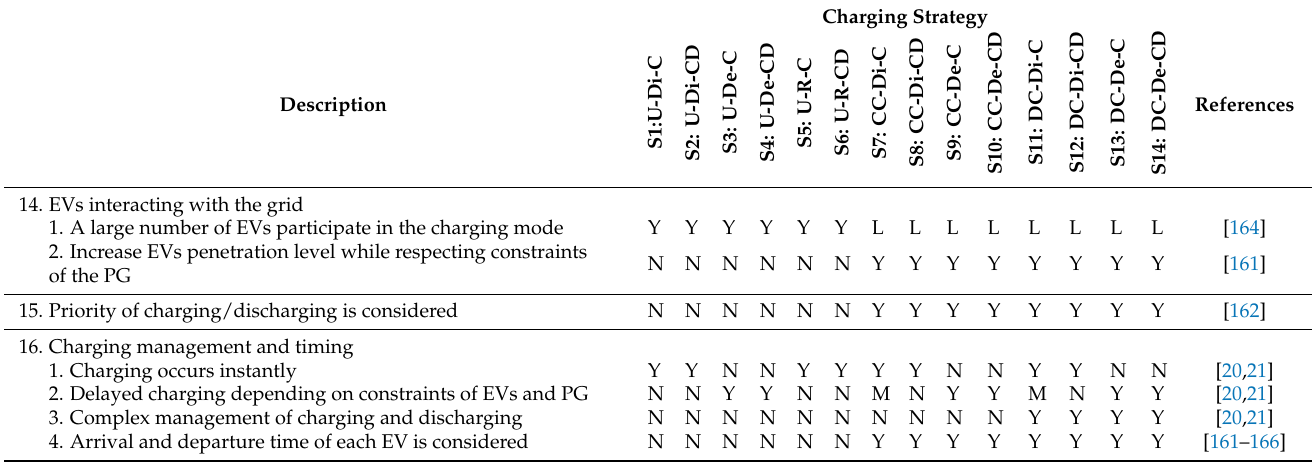
Table 7. Operating Aspects Comparison for Different EV Charging and Discharging